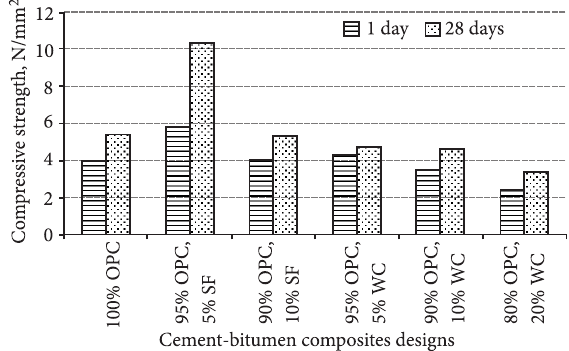
Fig. 3. Compressive strength performance for different cement- bitumen composite